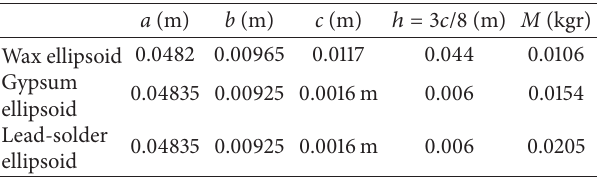
Table 1: Kane’s model parameters for three rattlebacks made of different materials.